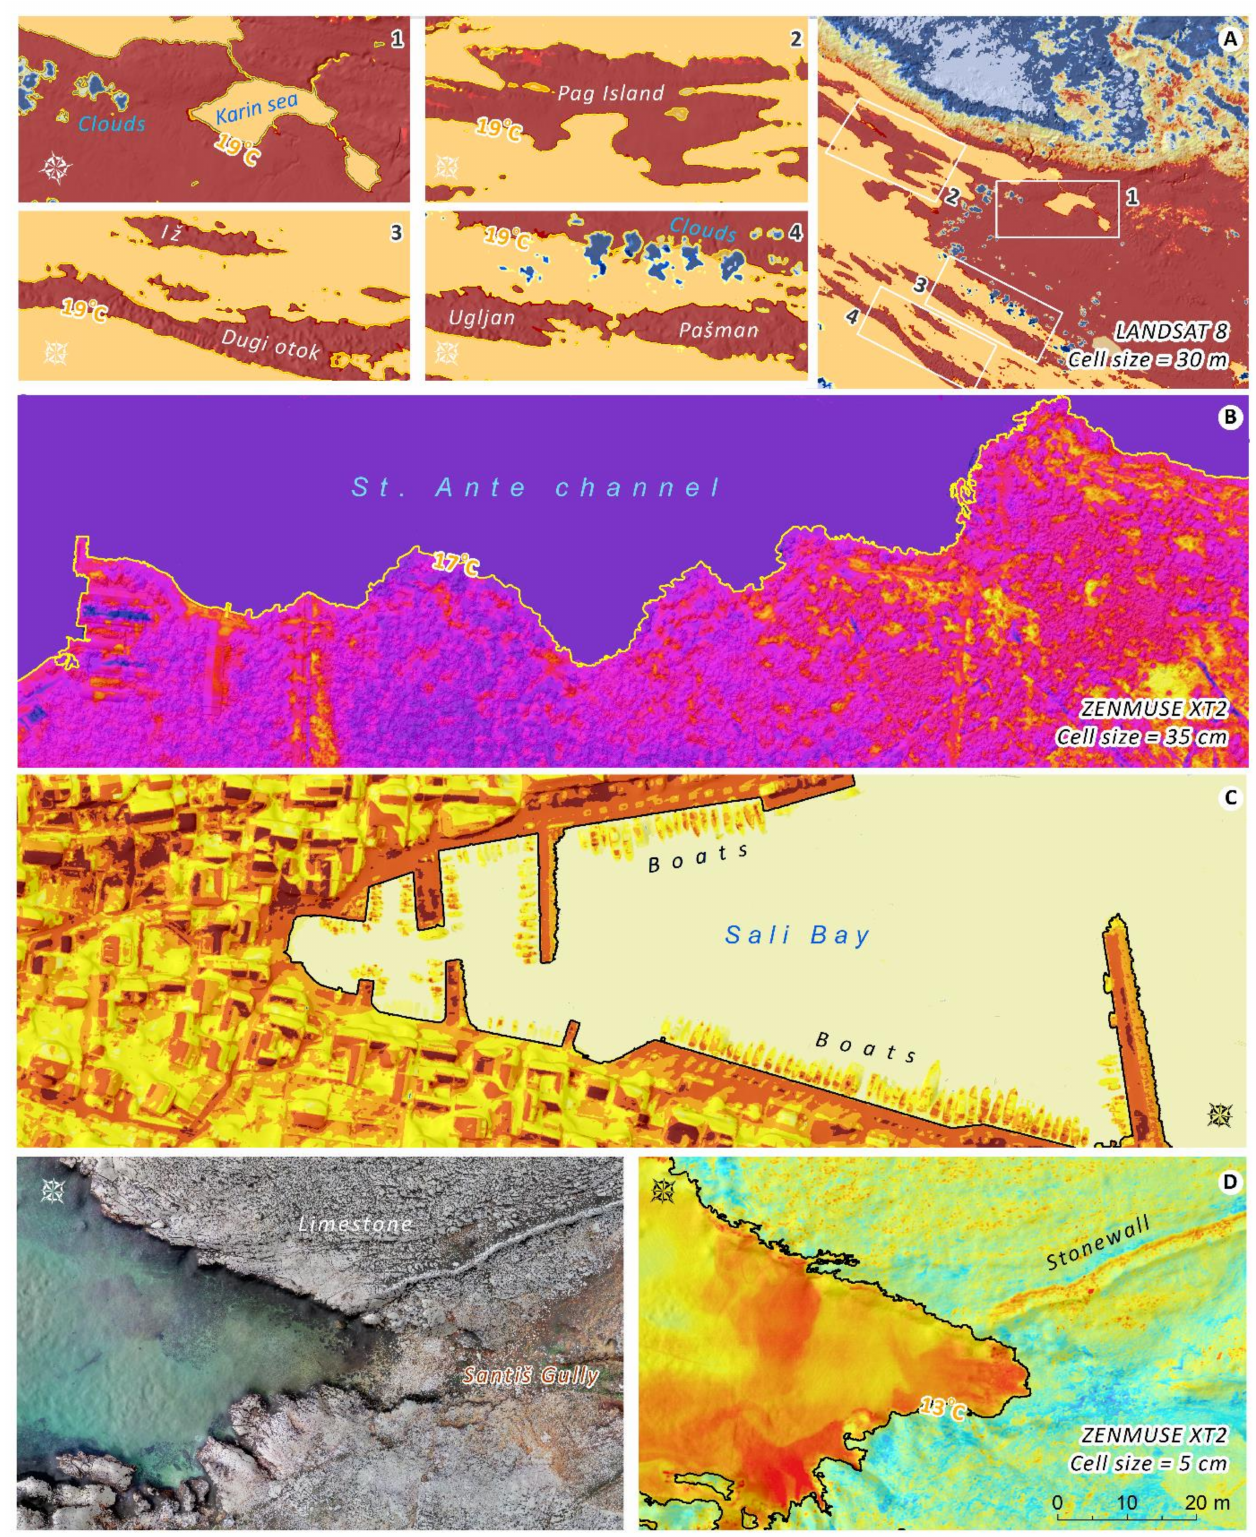
Figure 16. Land and sea surface temperatures generated for ( A ) the Zadar County wider area (spatial resolution = 30 M); ( B ) St. Ante channel (spatial resolution = 35 cm); ( C ) Sali Bay (spatial resolution = 7 cm); and ( D ) Santiš gully (spatial resolution = 5